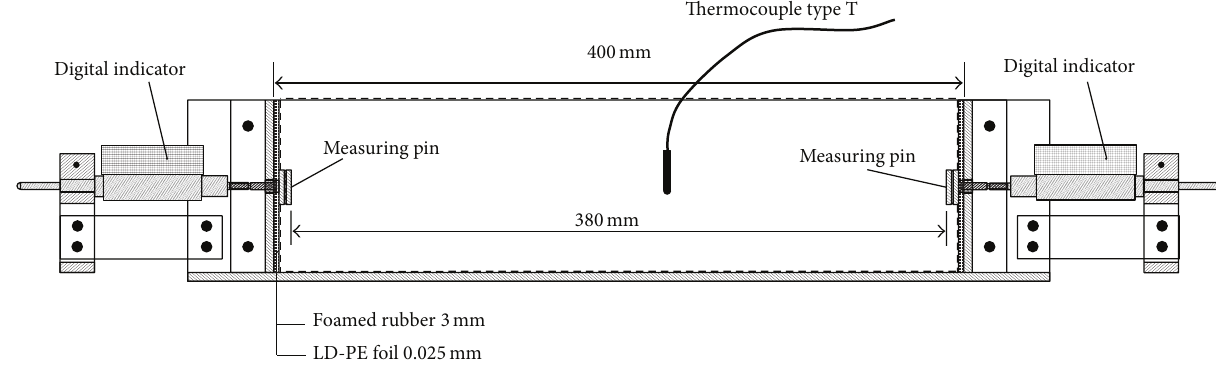
Figure 3: Schematic of experimental setup for measuring autogenous shrinkage [29].